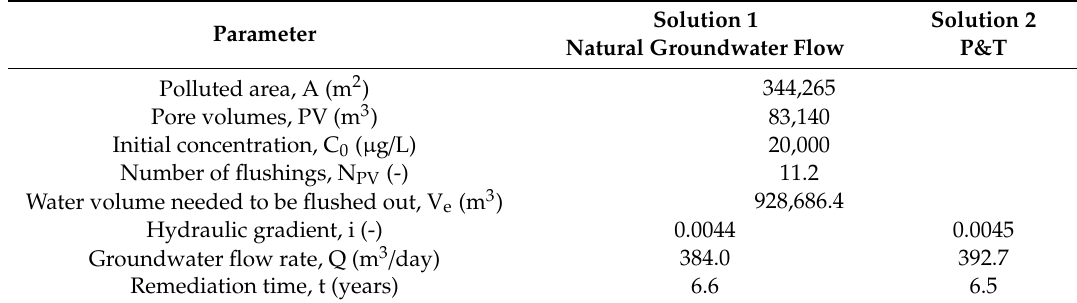
Table 4. Batch flushing model results for the field